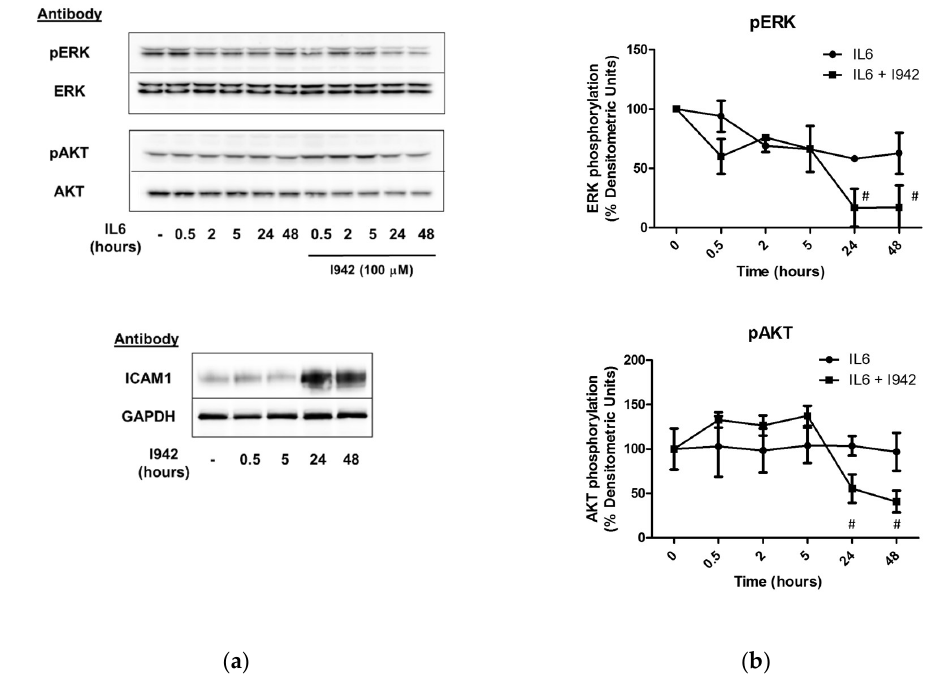
Figure 9. ( a ) HUVECs were stimulated for the indicated times with IL6 (5 ng / mL) plus sIL6R α (25 ng / mL) in the presence or absence of 100 µ M I942. Cell extracts were then immunoblotted with antibodies to pERK / ERK, pAKT / AKT, ICAM1 or GAPDH, as indicated. ( b ) Densitometric values from 3 separate immunoblots are shown on the left with significant decreases in the ratio of pERK / ERK and pAKT / AKT in cells stimulated with IL6 and I942, relative to stimulation with IL6 alone, being indicated; # p < 0.05 ( n = 3).